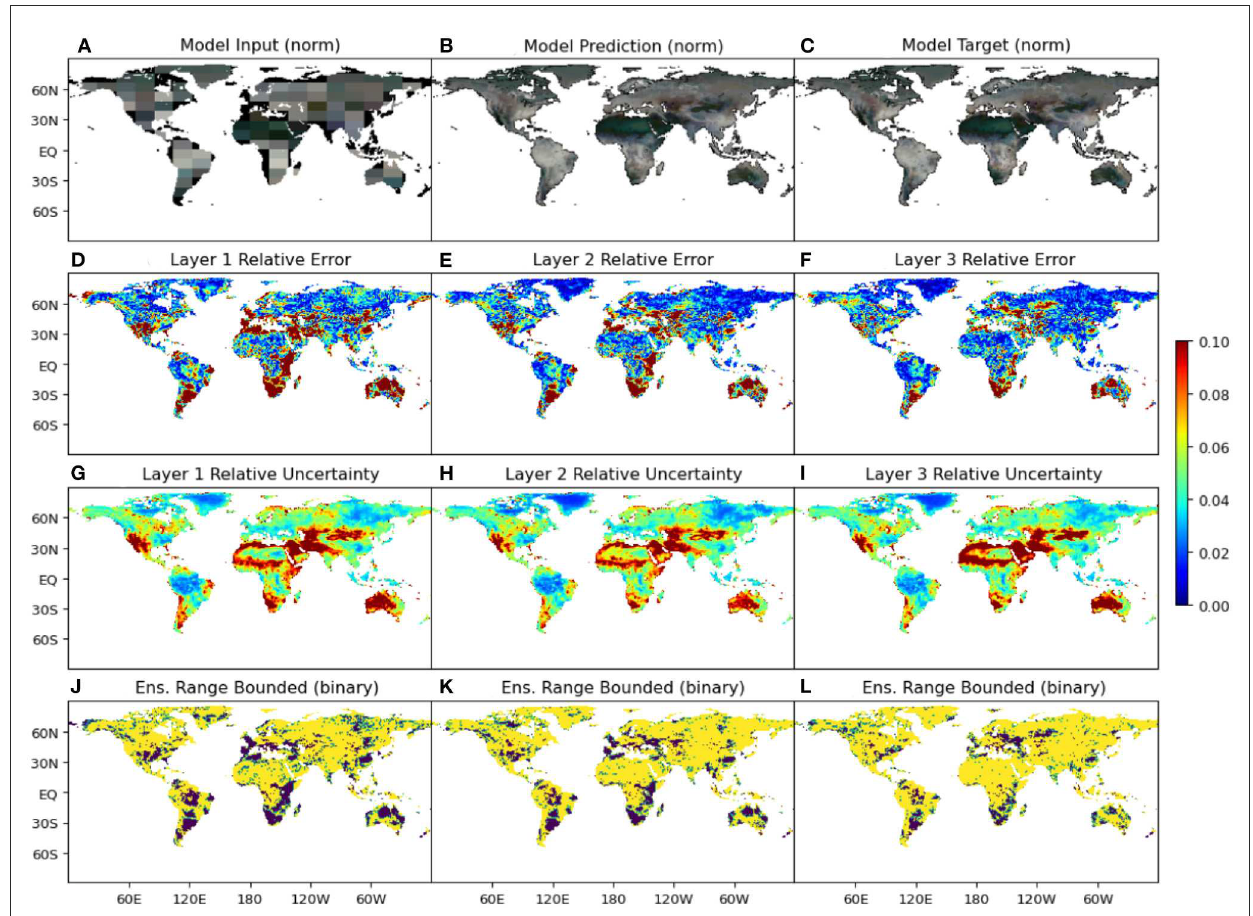
FIGURE5 Results for an unseen test snapshot from the three-layer global soil moisture dataset (Orth, 2021). The tessellated input (A) , the model prediction (B) , and the model target (C) , all normalized between 0 and 1, are depicted by a false-color composite plot with the moisture content in each layer being represented by an individual channel of an RGB image. Thus, the whole spectrum from darker to lighter colors is used to denote lower to higher moisture content, respectively, across all three layers. (D–F) Show the relative errors, (G–I) show the relative uncertainty fields, and (J–L) show the areas where the target value is bounded by the model ensemble prediction for the layers 0